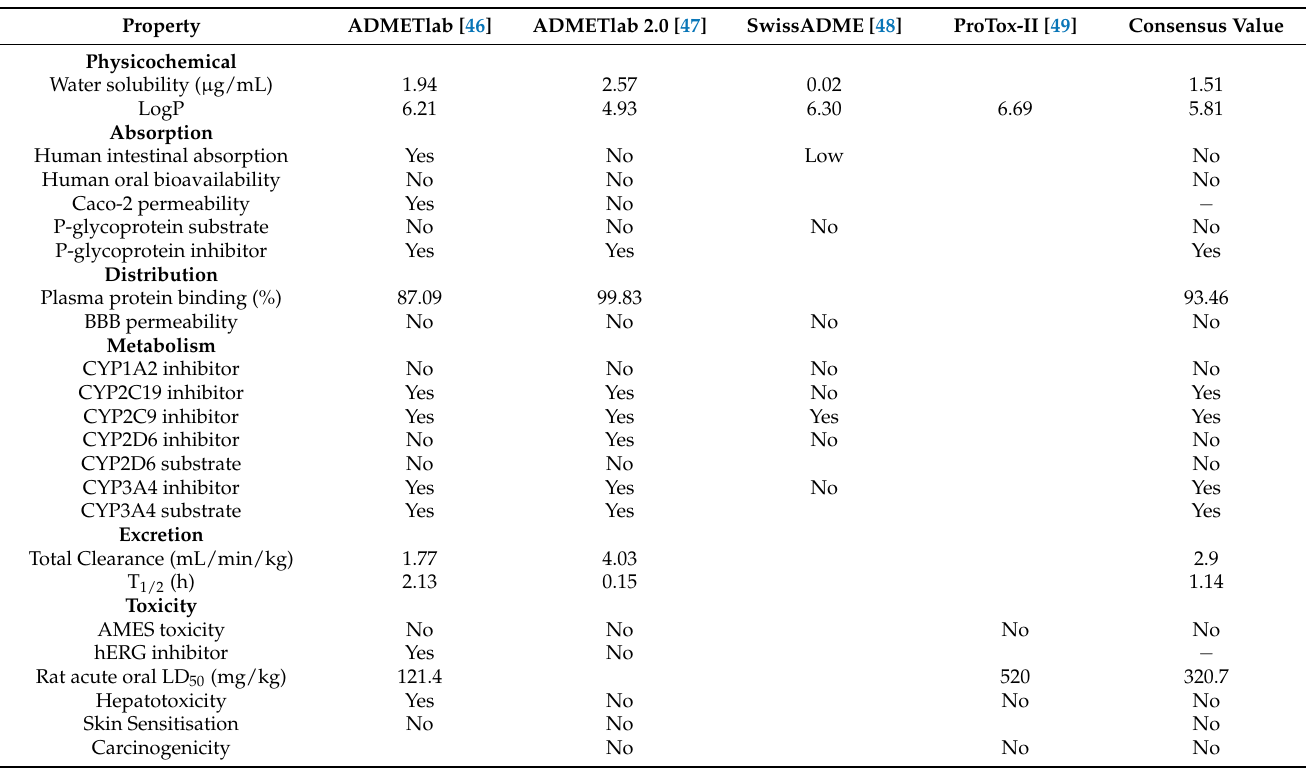
Table 2. ADMET properties predicted for compound 45